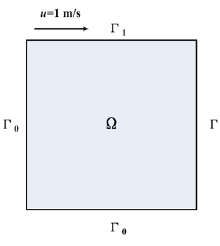
Figure 7. Lid-driven cavity